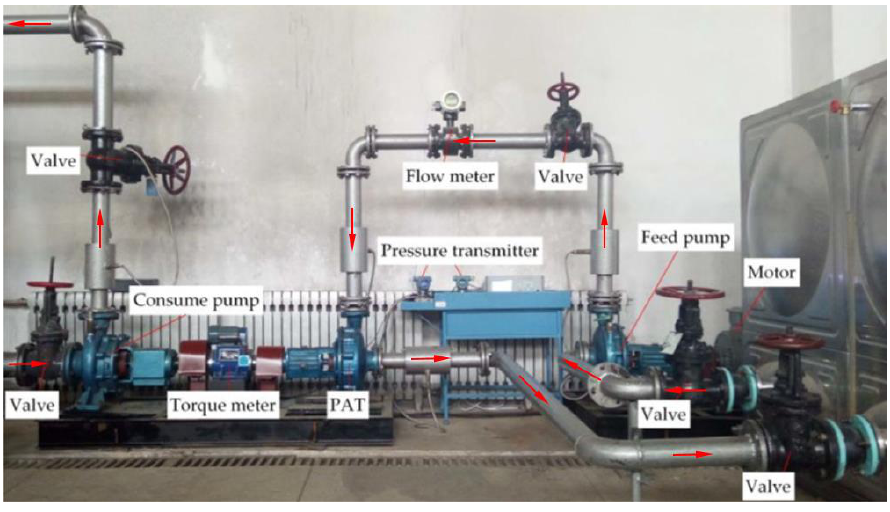
Figure 6. Test bench for PAT characteristics.